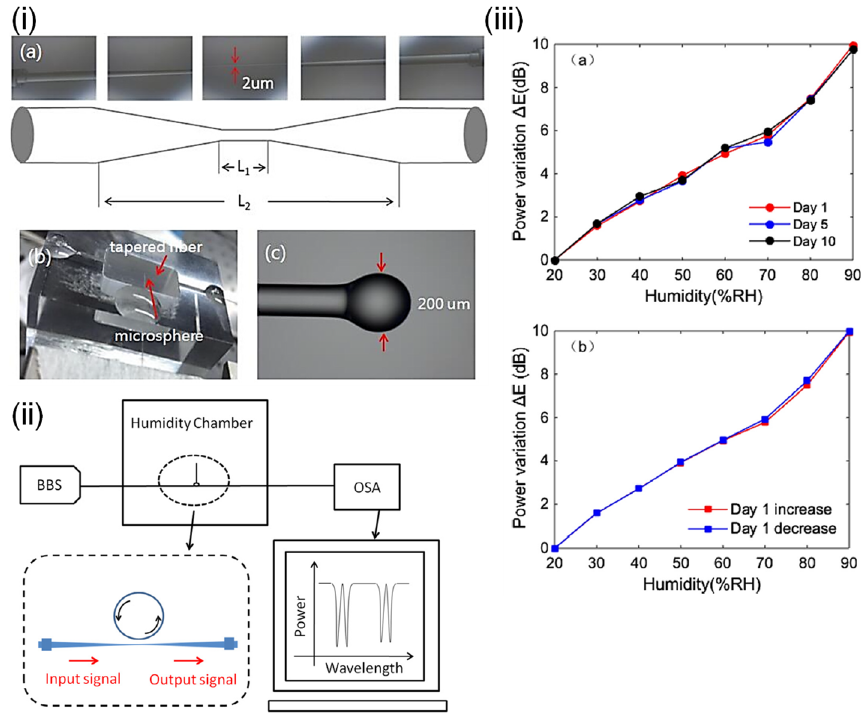
Figure 28. Point sensor. ( i ) ( a ) Schematic of tapered fiber. ( b ) Photograph of the packaged sensor. ( c ) Microscope image of the microsphere. ( ii ) Experimental setup. ( iii ) ( a ) RH vs. power variation over time. ( b ) Hysteresis graph. Adapted with permission from ref. [139]. Copyright 2018 Elsevier